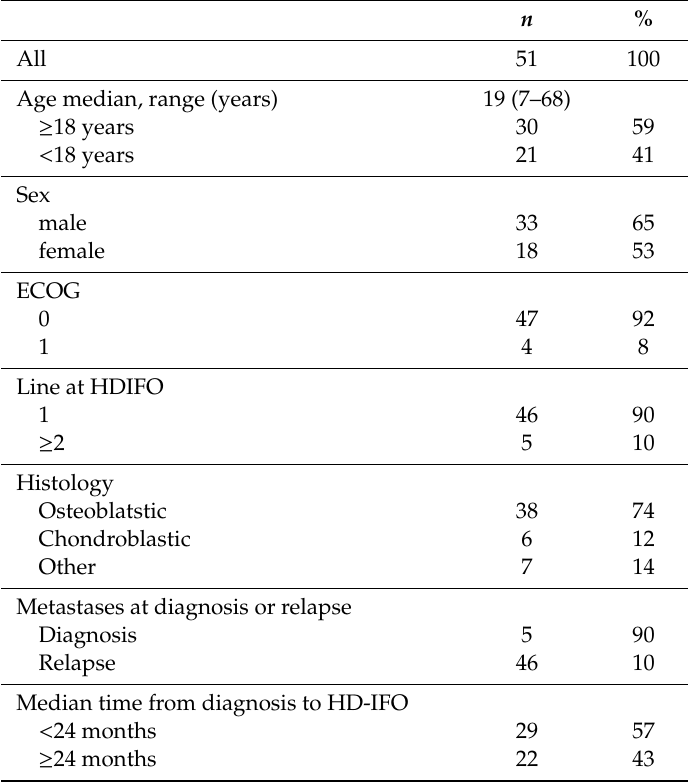
Table 2. Clinical characteristics, pattern of metastases and previous treatments in 51 patients treated with high-dose ifosfamide